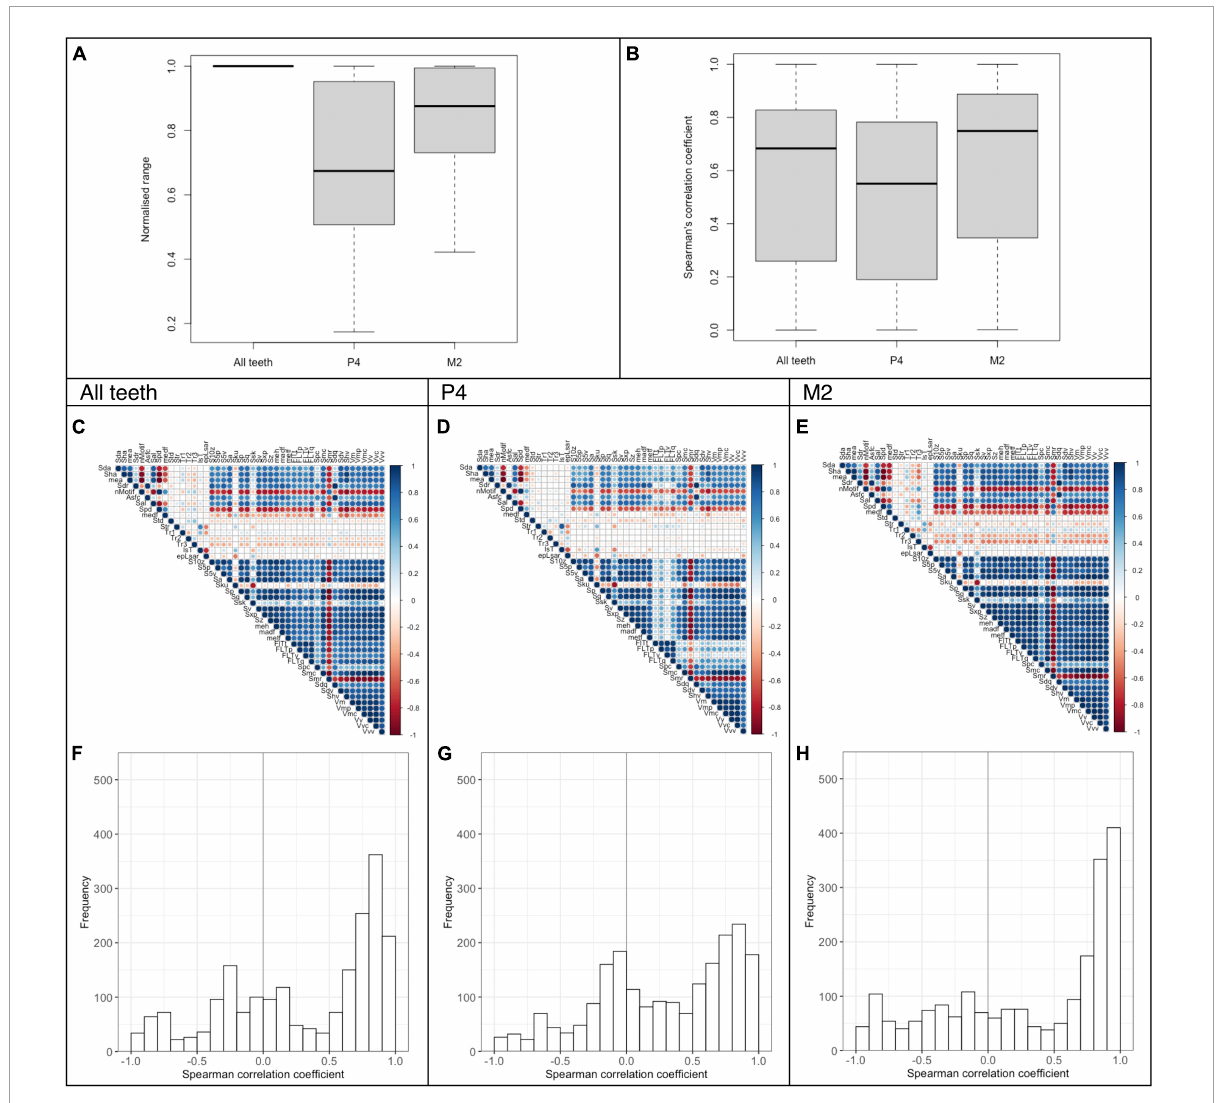
FIGURE1 Analysis of DMT parameters for guinea pigs fed different natural (lucerne, grass, bamboo) and pelleted diets with additional external abrasives (dataset B). The data is presented as a summary for all teeth (P4-M3, 228 scans) and separately for P4 (57 scans) and M2 (57 scans). The normalized data range and the Spearman’s correlations coefficients are given as boxplots (A,B) . The Spearman’s correlation of the DMT parameters is also shown as a correlation matrix (C–E) and a histogram (F–H)